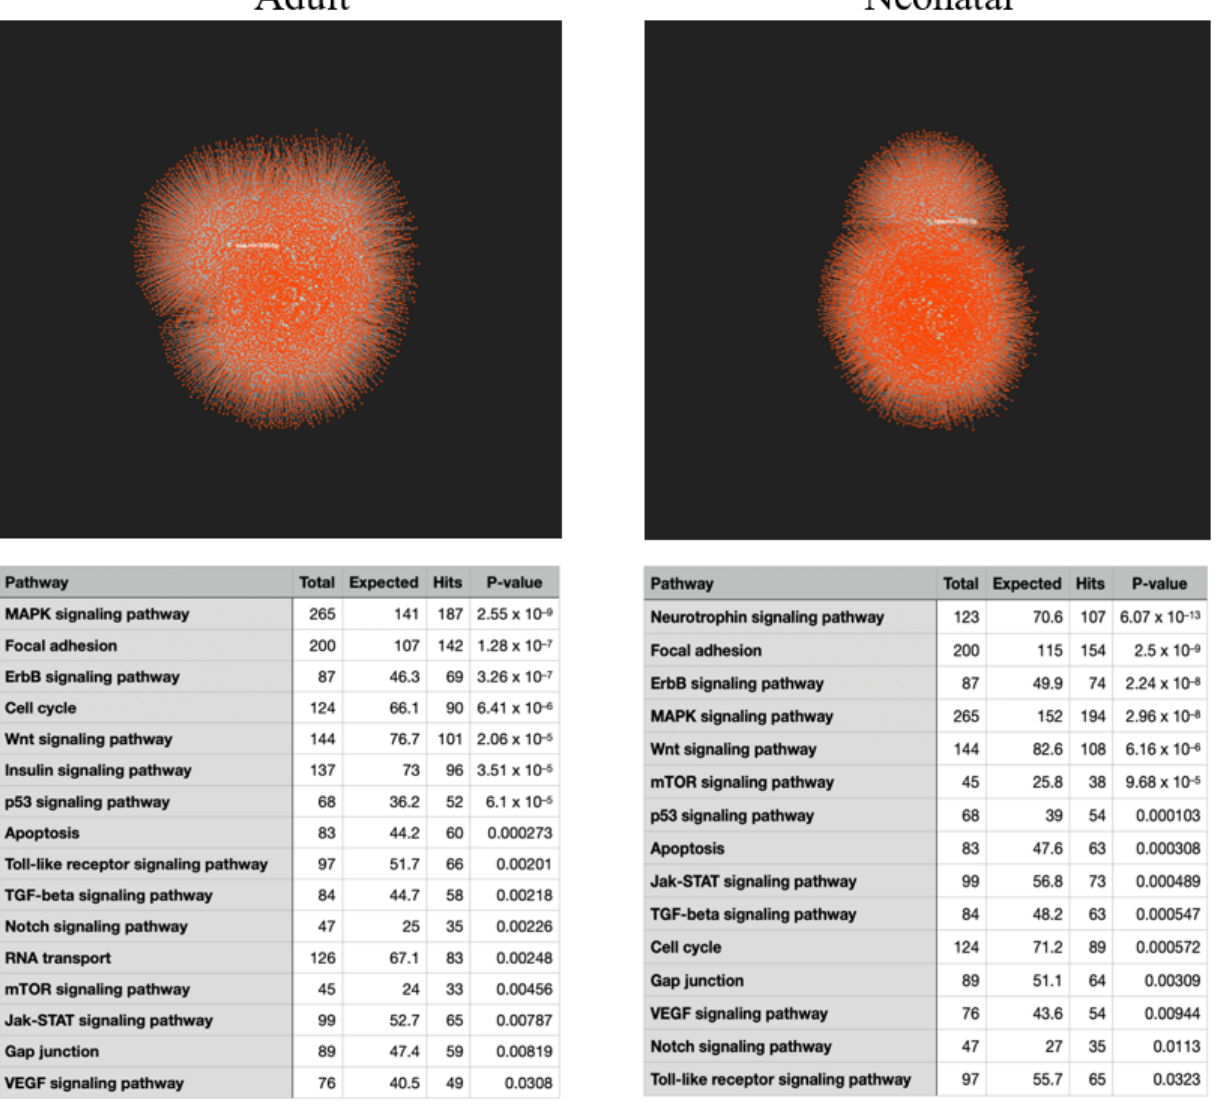
Figure 6. Predicted targets of miRNAs induced by spaceflight impact pathways related to cell cycle progression and survival. Differentially expressed miRNAs from flown adult and neonatal CPCs were mapped on a network using miRNet. KEGG analysis of predicted gene targets from adult and neonatal miRNAs reflects relevant regeneration and repair